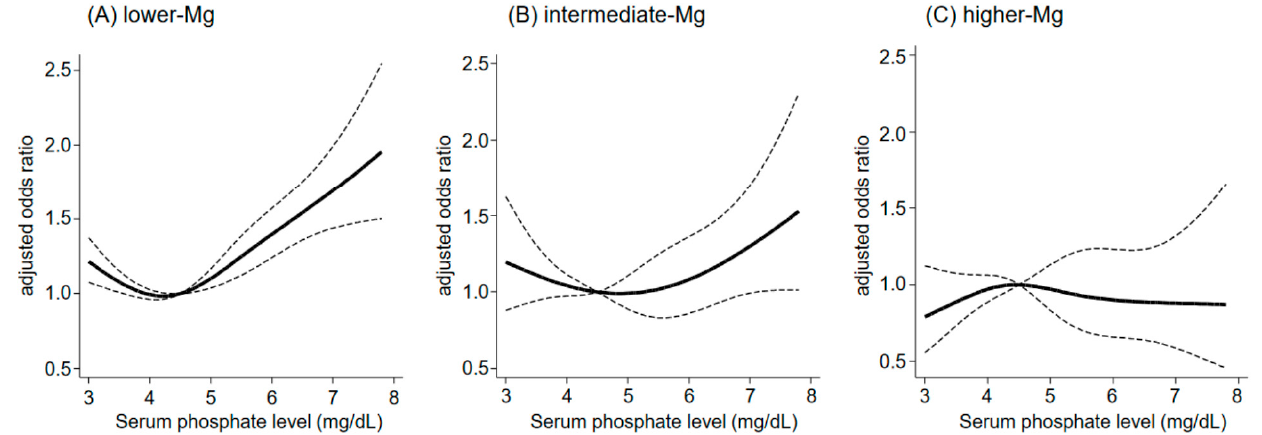
Figure 2. Serum magnesium levels modify the association between serum phosphate levels and cardiovascular death in hemodialysis patients. ( A ) High serum phosphate levels are associated with an increased risk of cardiovascular death in those with serum magnesium levels <2.7 mg/dL. However, this association is attenuated in those with serum magnesium levels 2.7–3.0 mg/dL ( B ) and 3.1 mg/dL or greater ( C ). The dashed lines represent 95% confidence intervals. Cited from Ref. [69]; Abbreviation: Mg, magnesium.